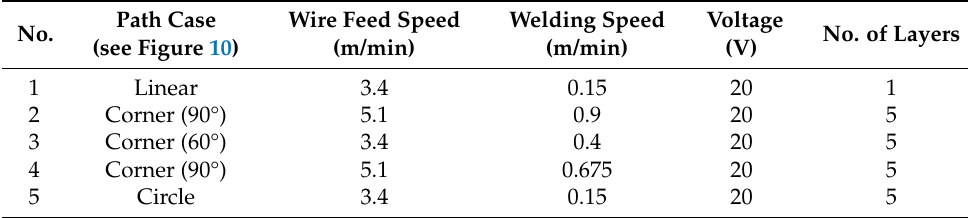
Table 1. List of parameters used for the experiments in Figure 11.